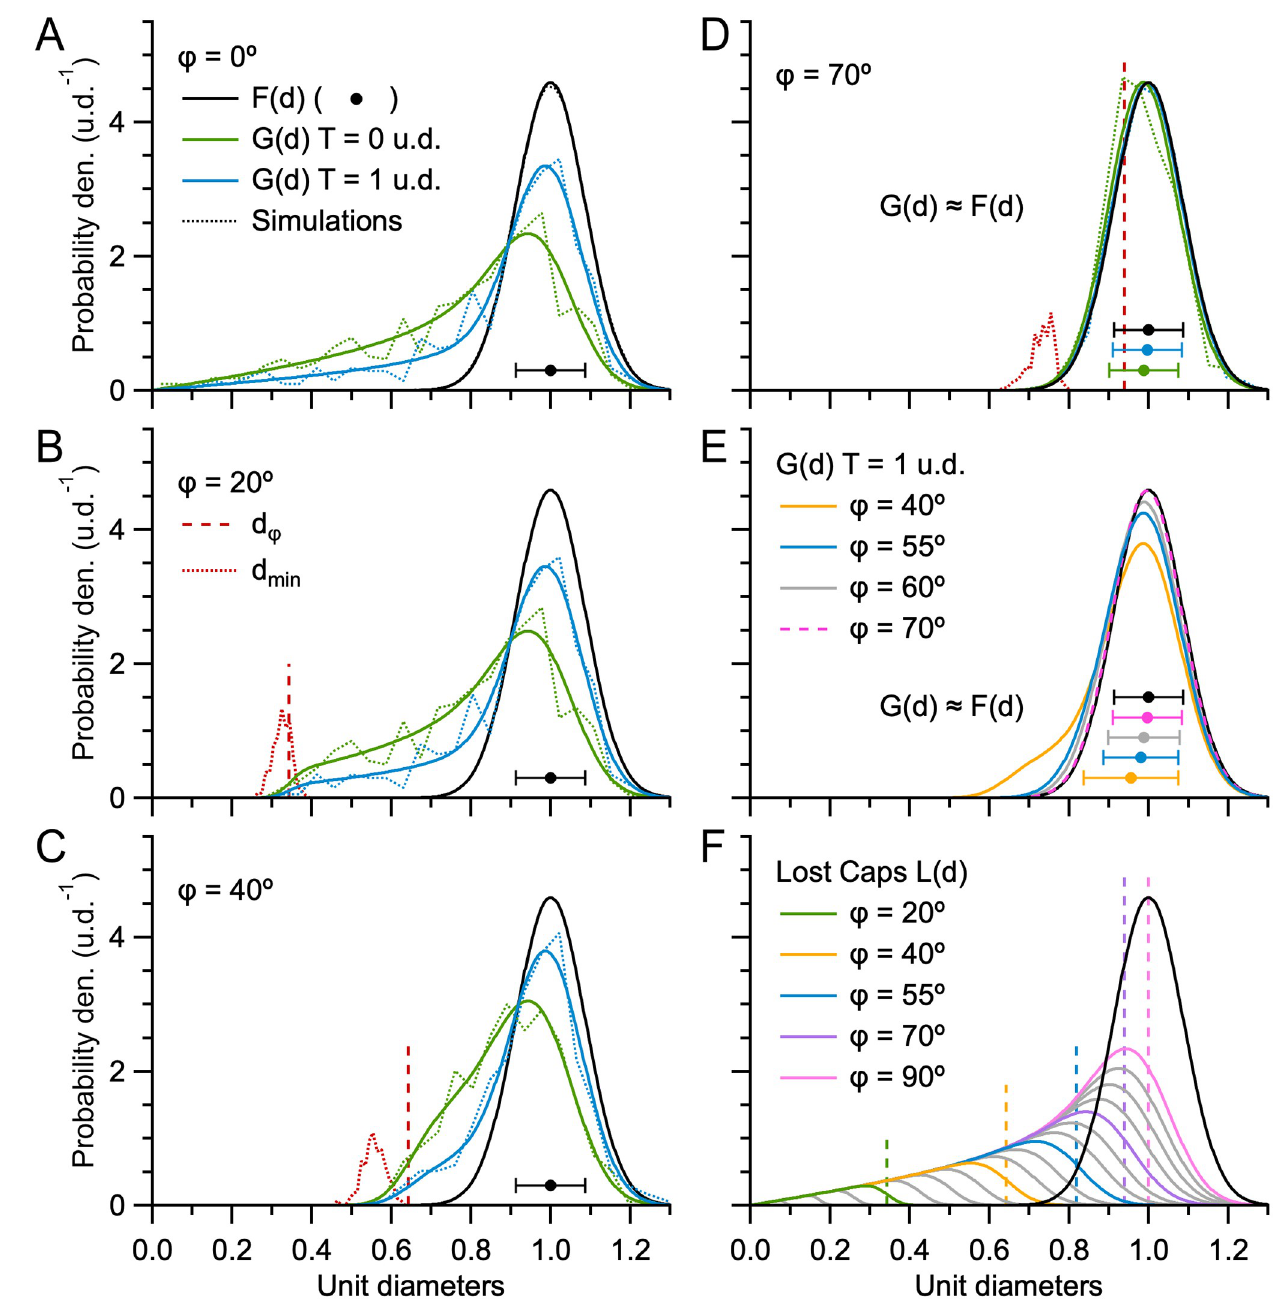
Fig 3. Effect of section thickness and lost caps on G(d). A. Probability density of 2D diameters (G(d)) computed via Eq 1, where ϕ = 0˚ and the probability density of 3D diameters (F(d)) is a Gaussian distribution with normalised mean (Eq 5; μ D ± σ D = 1.00 ± 0.09 u.d.; black line and circle ± error bars). For T = 0 u.d. (green line) conditions are that of Wicksell’s model [16] (Fig 1A) and for T = 1 u.d. (blue line) conditions are that of Bach’s model [38] (Fig 1B). Because no caps are lost, both G(d) have tails extending to d = 0 u.d. Dotted lines denote G(d) of equivalent Monte Carlo simulations computed from ~500 diameters using 0.04 u.d. bins. B–D. Same as A for ϕ = 20, 40 and 70˚. Here, the tails of G(d) are limited to 0.3, 0.5 and 0.7 u.d. For ϕ = 70˚, G(d) � F(d) (green and blue circles denote μ d ± σ d ) since most caps are lost. Comparison of the distribution of the minimum observed 2D diameter (d min , red dotted line, computed from simulations for both T = 0 and 1 u.d., probability densities scaled by 0.07) to d = μ D � sin ϕ (vertical red dashed line) shows d min < d , especially at larger ϕ . E. ϕ ϕ For ϕ > 55˚, G(d) � F(d). F. Distribution of lost caps, L(d), for ϕ = 5–90˚ in steps of 5˚ (gray and colored solid lines; Materials and Methods) compared to F(d) (black line). Vertical dashed lines denote d . Note, L(d, ϕ = 90˚) = G(d, ϕ = ϕ